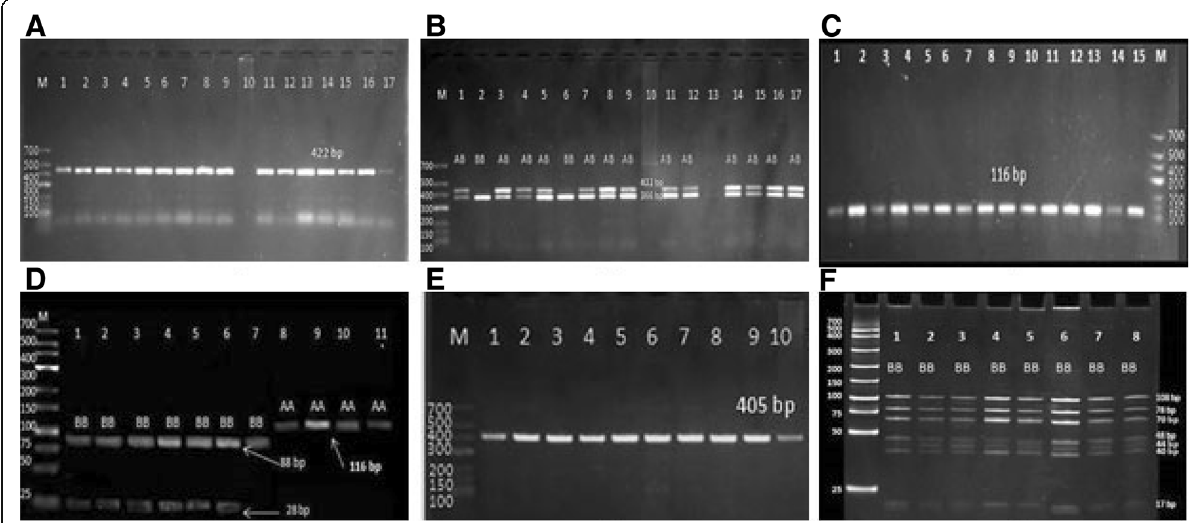
Fig. 1 Electrophoretic pattern of PCR-amplified fragment from three loci on GH gene named GH1, GH2, GH6 and their digestions. a Agarose gel electrophoresis of GH1 -PCR fragment (422 bp). Lanes M (25 bp DNA ladder); 1, 2 3, 4, 5, 6 (Barki); 7, 8, 9, 11 (Damascus); and 12, 13, 14, 15, 16, 17(Zaraibi). b Agarose gel electrophoresis of GH1-HaeIII/RFLP fragments. Lane M, 25 bp DNA ladder; lanes (1, 3, 4,5, 7, 8, 9, 11, 12, 14, 15, 16, 17) genotype AB (422, 366, and 56 bp); and lanes (2, 6) genotype BB (366 and 56 bp). c Agarose gel electrophoresis of GH2 -PCR fragment (116 bp). Lane M, 25 bp DNA ladder. Lanes (1, 2, 3, 4, 5) Barki; (6, 7, 8. 9, 10) Damascus; and lanes (11, 12, 13, 14, 15) Zaraibi breeds. d Agarose gel electrophoresis Hae III / RFLP fragments. Lane M, 25 bp DNA ladder; lanes (1, 2, 3, 4, 5, 6, 7) genotype BB (88 and 28 bp); and lanes (8, 9, 10, 11) genotype AA (116 bp). e Agarose gel electrophoresis of GH6 -PCR fragment (405 bp). Lane M, 25 bp DNA ladder. Lanes (1, 2, 3) Barki; (4, 5, 6) Damascus; and lanes (7, 8, 9, 10) Zaraibi breeds. f Polyacrylamide gel electrophoresis for GH6-HaeIII/ RFLP. Lane M (25 bp DNA ladder) and 1 → 8 (genotype BB with 108, 78, 70, 48, 44, 40, and 17